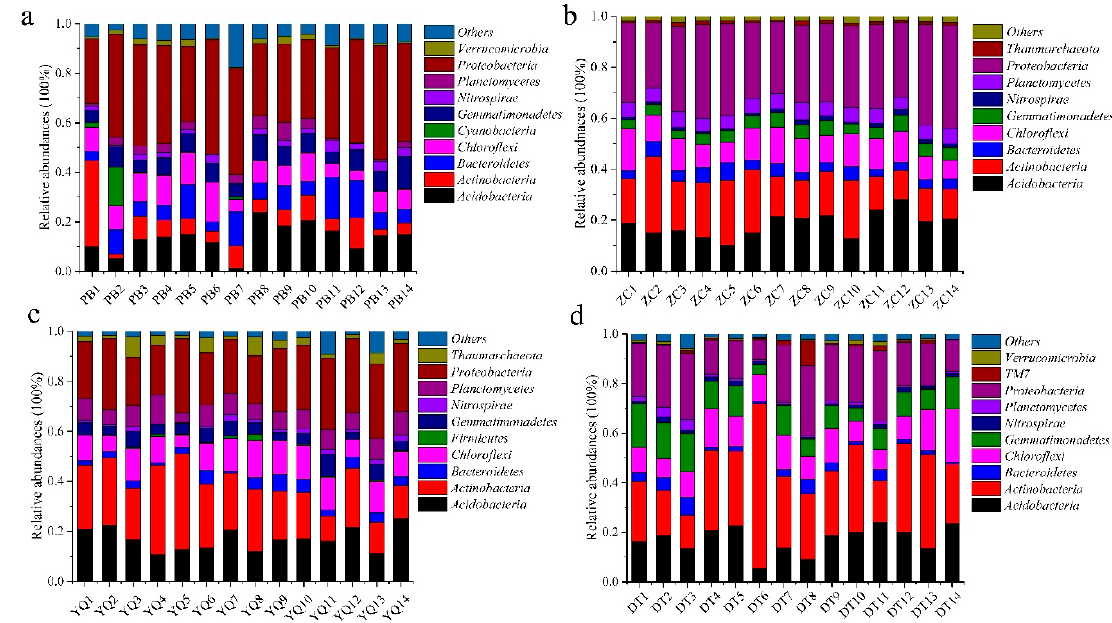
Figure 2. Bacterial categories (( a ), ( b ), ( c ), and ( d )) in soil samples across Peibei (PB), Zoucheng (ZC), Yangquan (YQ), and Datong (DT) mining areas.